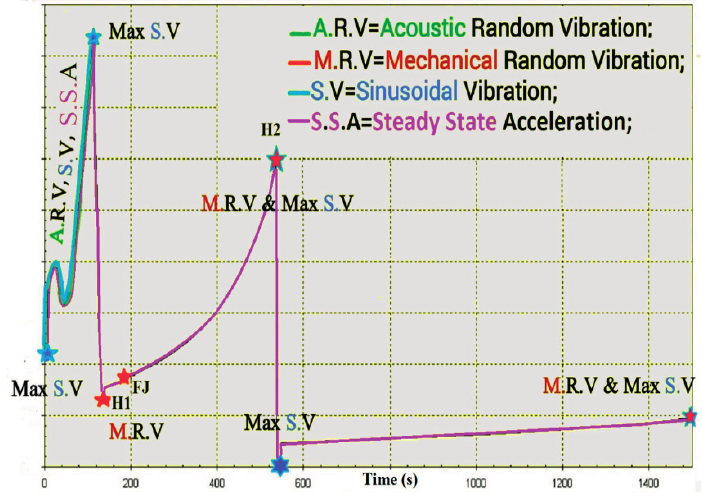
Figure 7. External loads applied to the Ariane 5 launch vehicle.